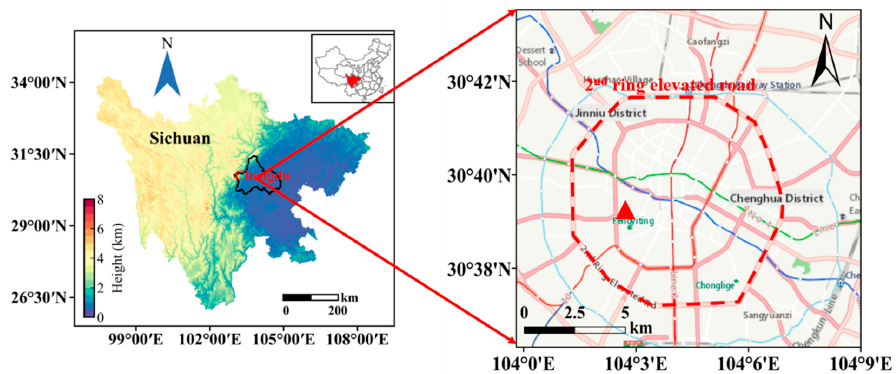
Figure 1. The location of the sampling site in urban areas of Chengdu.